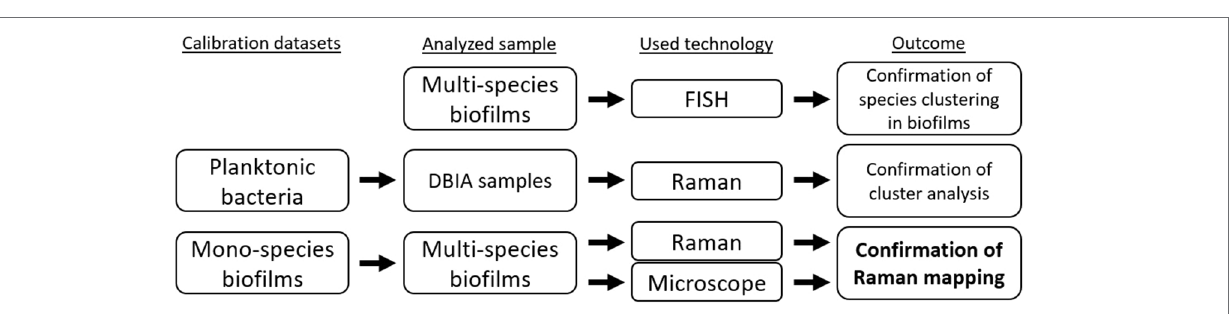
FIGURE 2 | Experimental design setup for the differentiation and confirmation of Raman mapping in a two-species biofilm